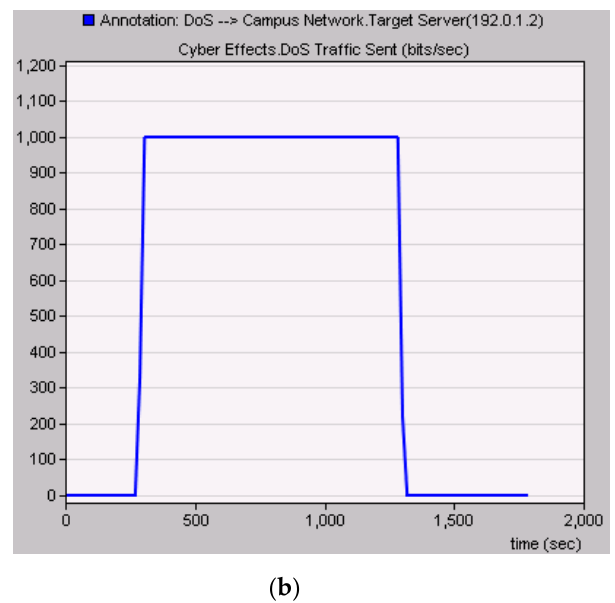
Figure 14. DoS tra ffi c sent from Host to Target Sever: ( a ) DoS Tra ffi c sent in real-world network of Figure 14. DoS traffic sent from Host to Target Sever: ( a ) DoS Traffic sent in real-world network of Figure 11. ( b ) DoS Tra ffi c sent in the proposed analysis system of Figure 12. Figure 11. ( b ) DoS Traffic sent in the proposed analysis system of Figure 12. Table 4. Performance evaluation